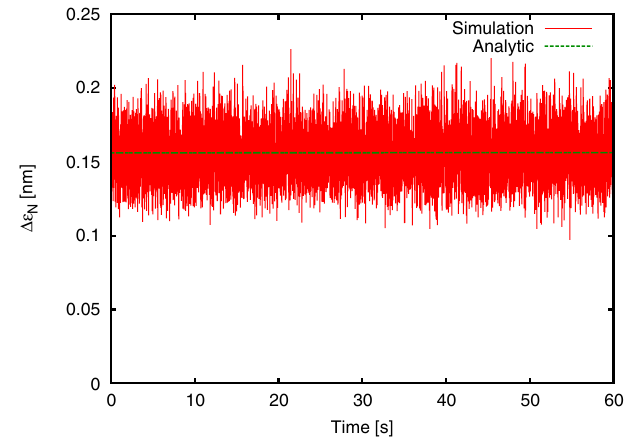
FIG. 19. (Color) Emittance growth along the CLIC main linac during 1 min of operation. The analytic results are seen to be in perfect agreement with simulations. Compared to the constant (cid:6) 0 : 155 nm , the increase caused by emittance growth of (cid:1) (cid:2) N ground motion is not visible after only 1 min.